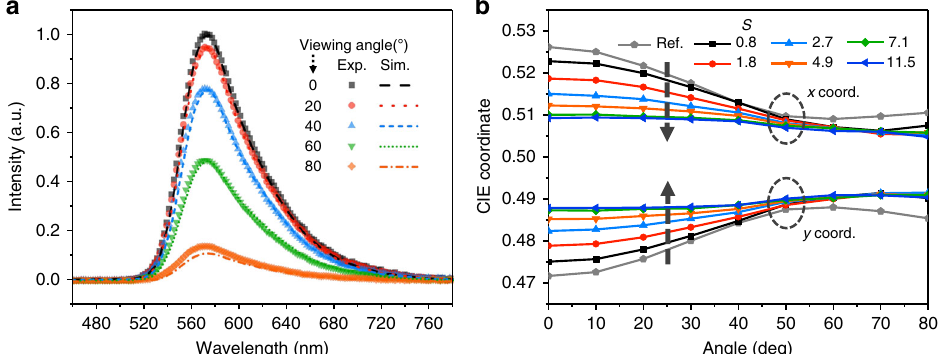
Fig. 5 Angular spectral dependence of organic light-emitting diodes (OLEDs) with the SiO 2 scattering layers. a Experimental (semitransparent symbols) and simulated (dashed lines) normalized angular spectra of OLEDs with a 3 wt.% scattering layer (scatterance ( S ) = 7.1). b CIE coordinates of angular spectra of the devices with different SiO 2 -based scattering